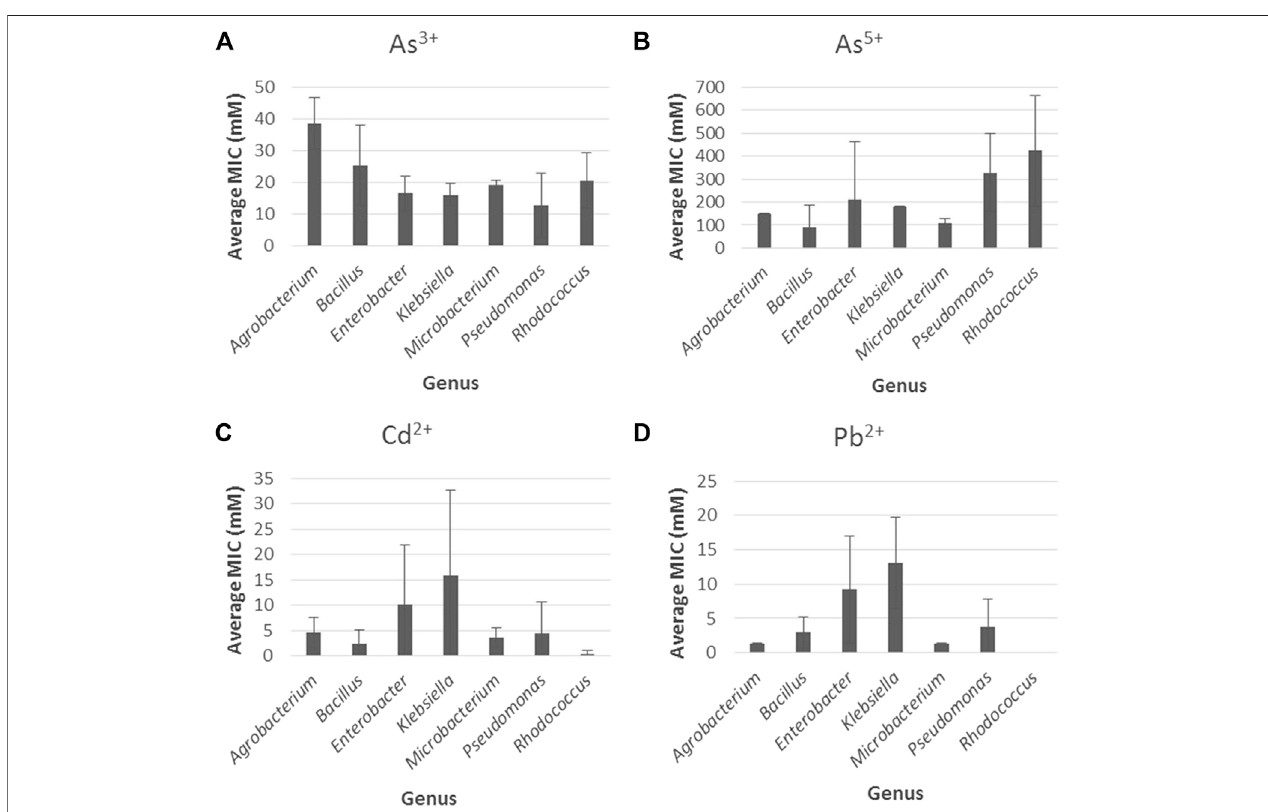
FIGURE 6 | Bacterial metal tolerance expressed as the average of the MIC values (mM) with the standard error for (A) Arsenite (As 3 + ), (B) Arsenate (As 5 + ), (C) Cadmium(Cd 2+ )and (D) lead(Pb 2+ ) forthegenerawiththehighestresistanceagainst heavy metals ( Agrobacterium,Bacillus, Klebsiella,Enterobacter,Microbacterium, Pseudomonas, Rhodococcus